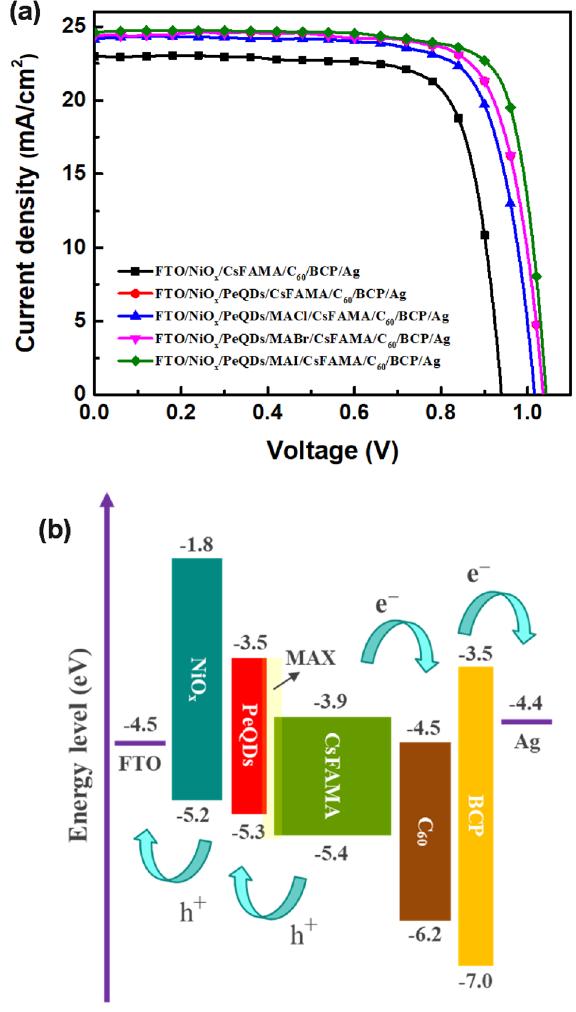
Figure 7. ( a ) J–V curves of the best-performing PeSCs based on the CsFAMA, PeQDs/CsFAMA, and PeQDs/ MAX (Cl, Br, I)/CsFAMA. ( b ) Band energy diagram of the whole structure.